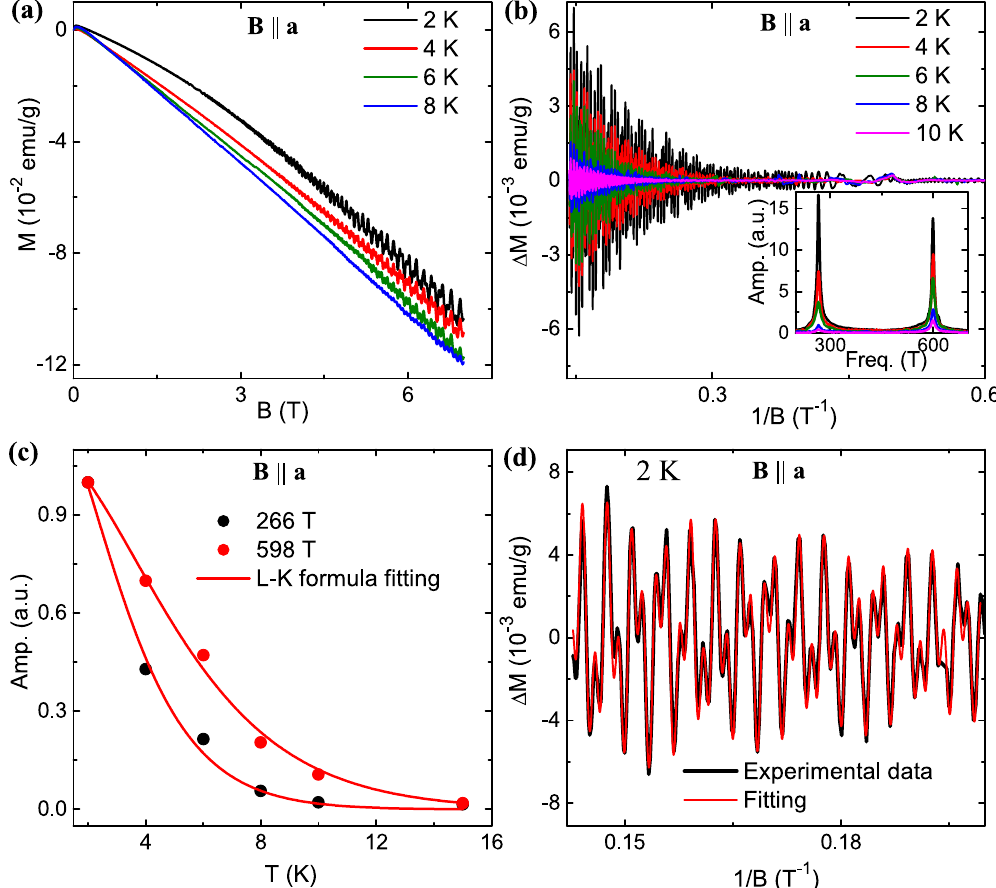
Figure 4. dHvA oscillation in LaBi single crystal. ( a ) Magnetic moment plotted as a function of magnetic field with field parallel to a -axis. ( b ) dHvA oscillation obtained after background subtraction. Inset shows the corresponding FFT result. ( c ) Temperature dependence of dHvA oscillation amplitude, fitted using the L-K formula for B || a -axis. ( d ) Two-band L-K formula fitting of dHvA